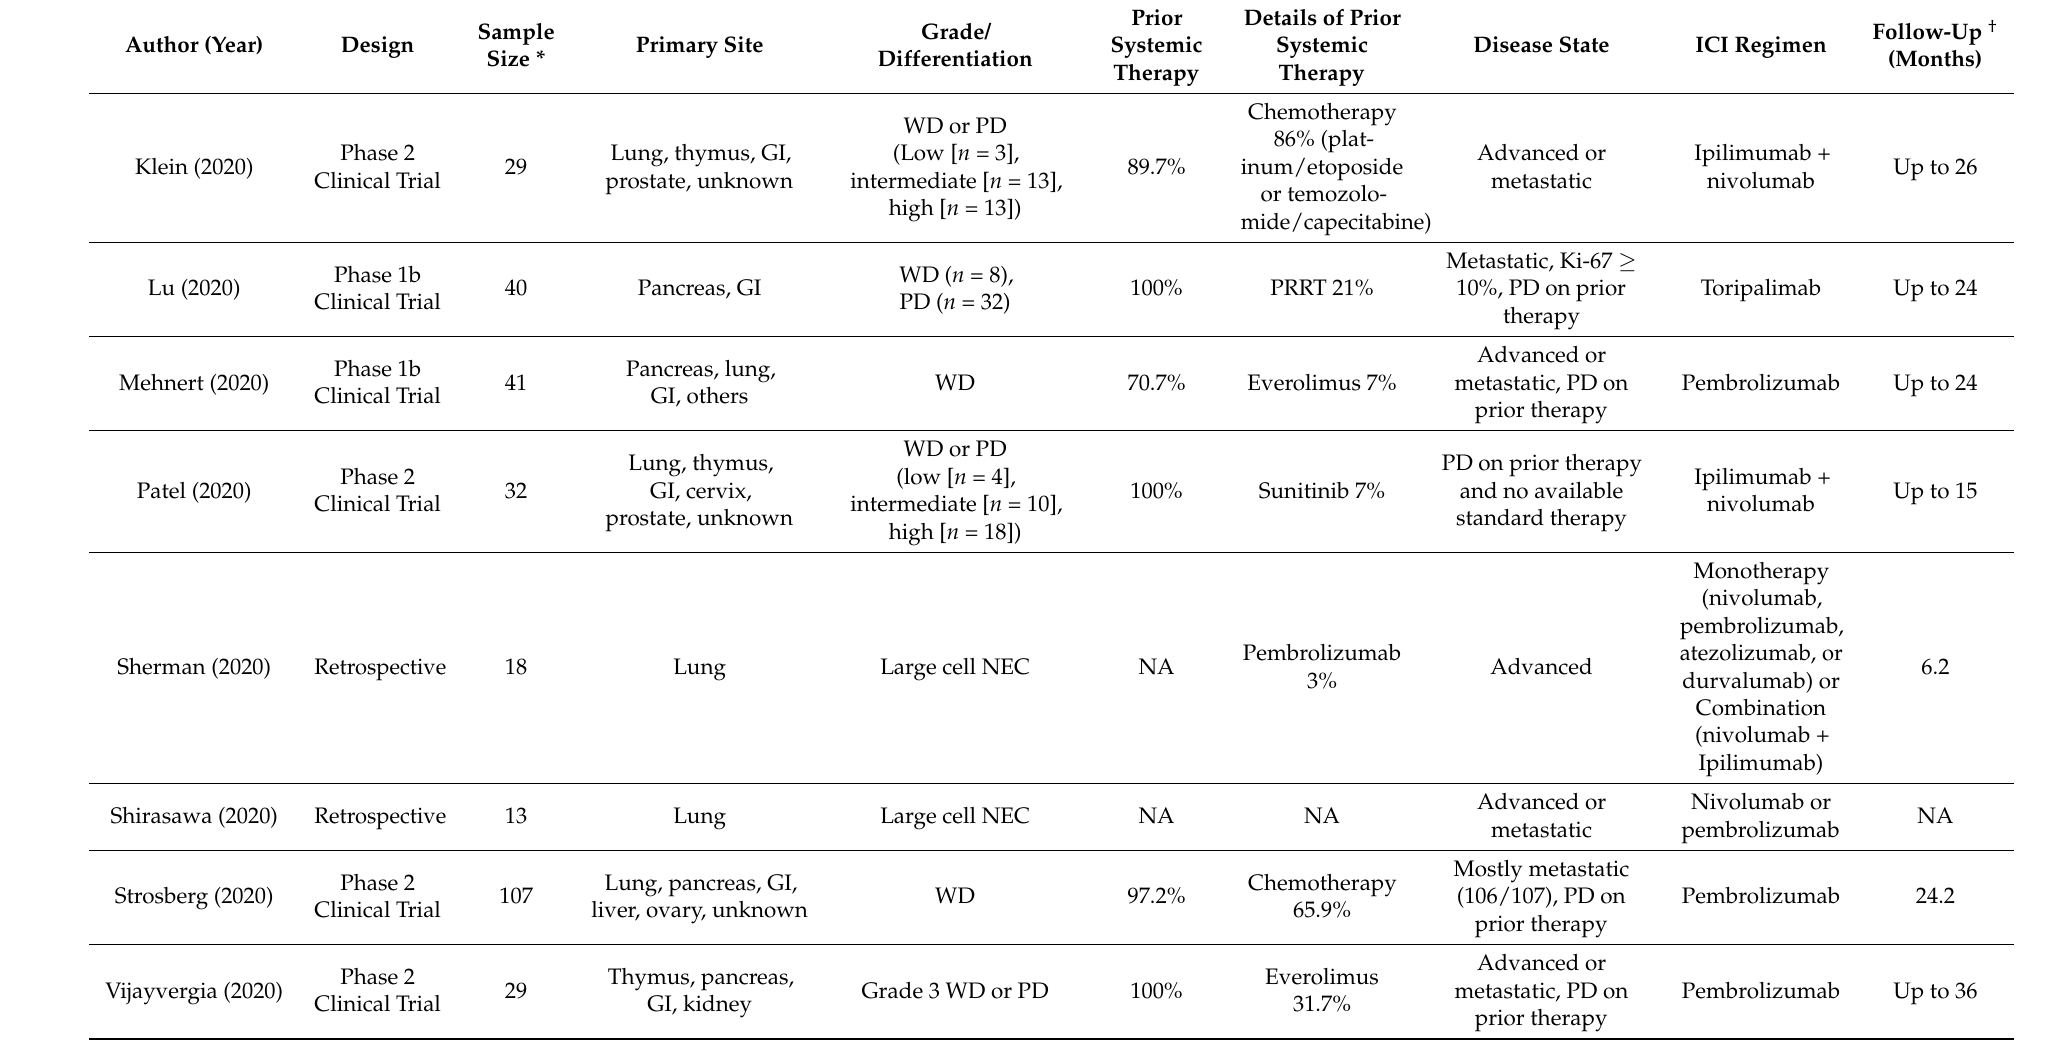
Table 1. Characteristics of the studies included in the